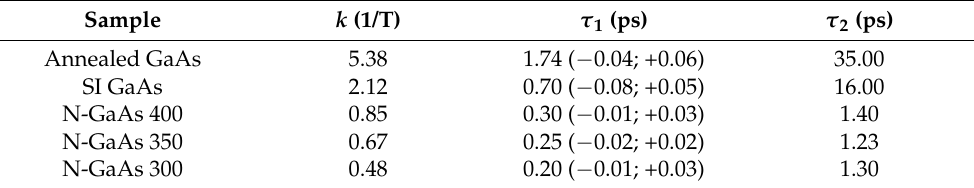
Table 1. Data of the slope k , the trapping time τ 1 , and the electron–hole recombination time τ 2 . k values were extracted from Figure 6 as linear fits, while the time constants were obtained by applying a bi-exponential fit to each experimental pump–probe waveform presented in Figure 7. Error margins in the τ 1 column correspond to the range of fitting coefficients within the >95% confidence bounds.